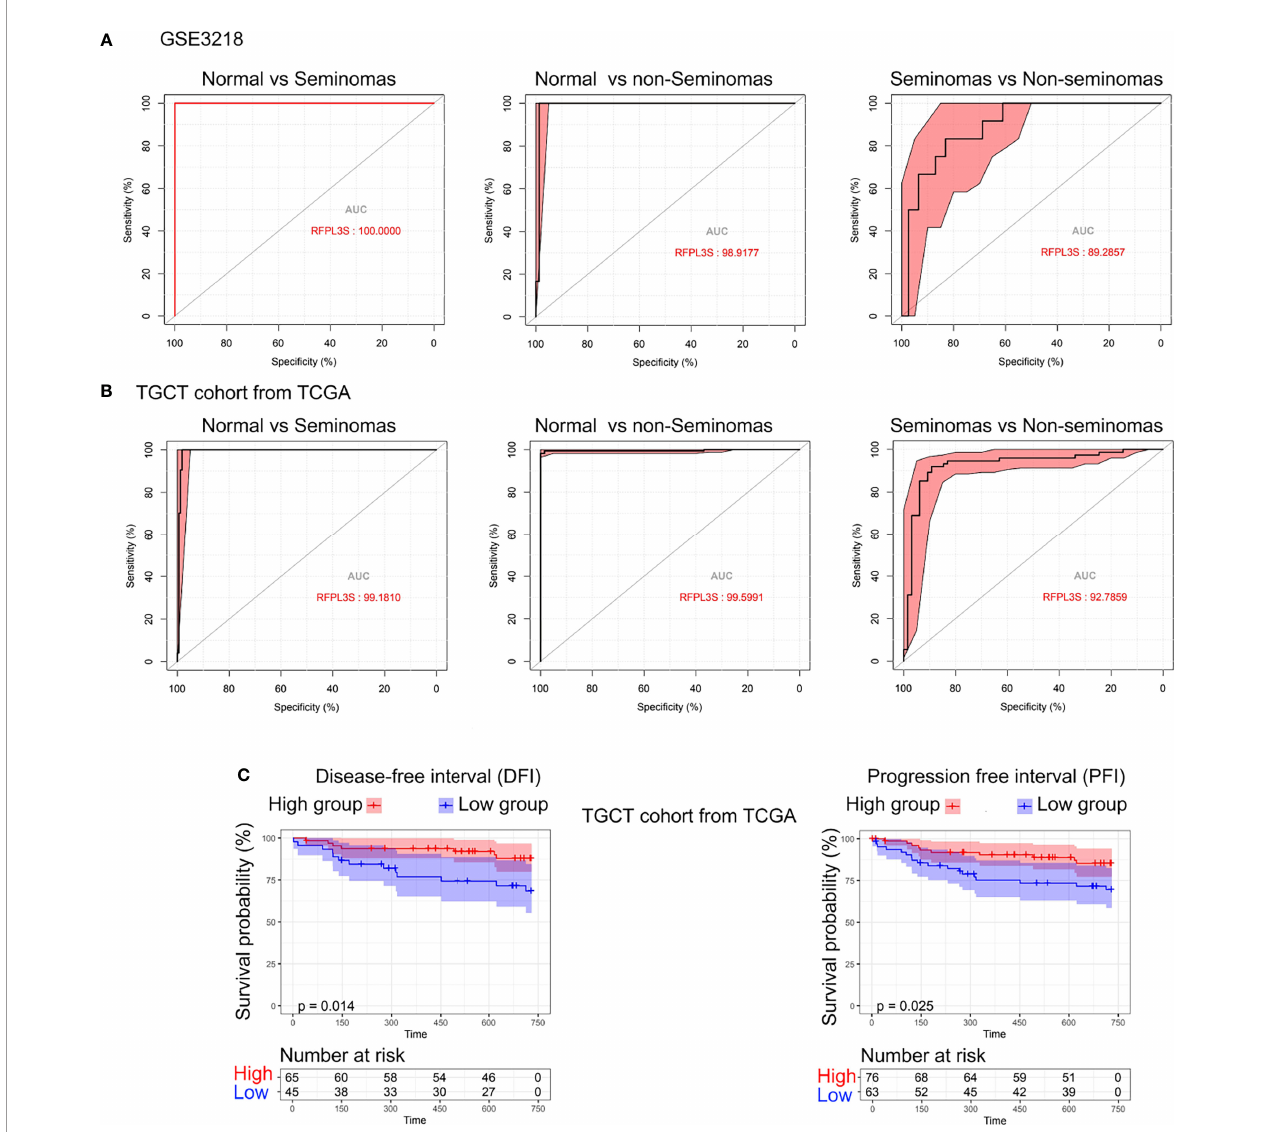
FIGURE 2 | The diagnostic and prognostic value of RFPL3S in TGCT. (A) Receiver operating characteristic (ROC) curve evaluated the diagnostic value of RFPL3S in distinguishing normal (N) from seminoma (SEM), normal (N) from non-seminoma (NSEM), and non-seminoma (NSEM) from seminoma (SEM) in GEO GSE3218 cohort. (B) ROC curve evaluated the diagnostic value of RFPL3S in distinguishing normal (N) form seminoma (SEM), normal (N) from non-seminoma (NSEM), and non-seminoma (NSEM) from seminoma (SEM) in TGCT cohort from TCGA. (C) Correlation between RFPL3S and disease-free interval (DFI) and progression free interval (PFI) of TGCT cohort from TCGA. Patients with high RFPL3S expression had higher DFI and